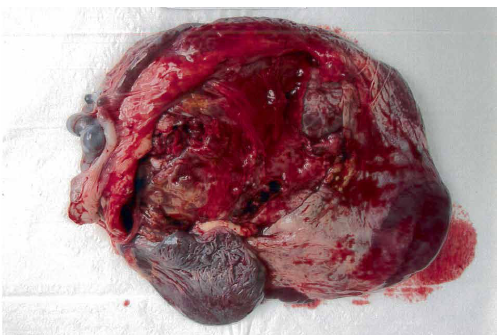
Figure 2: Incomplete placenta. Parts of placenta membrane were left in-situ to avoid bowel injury.